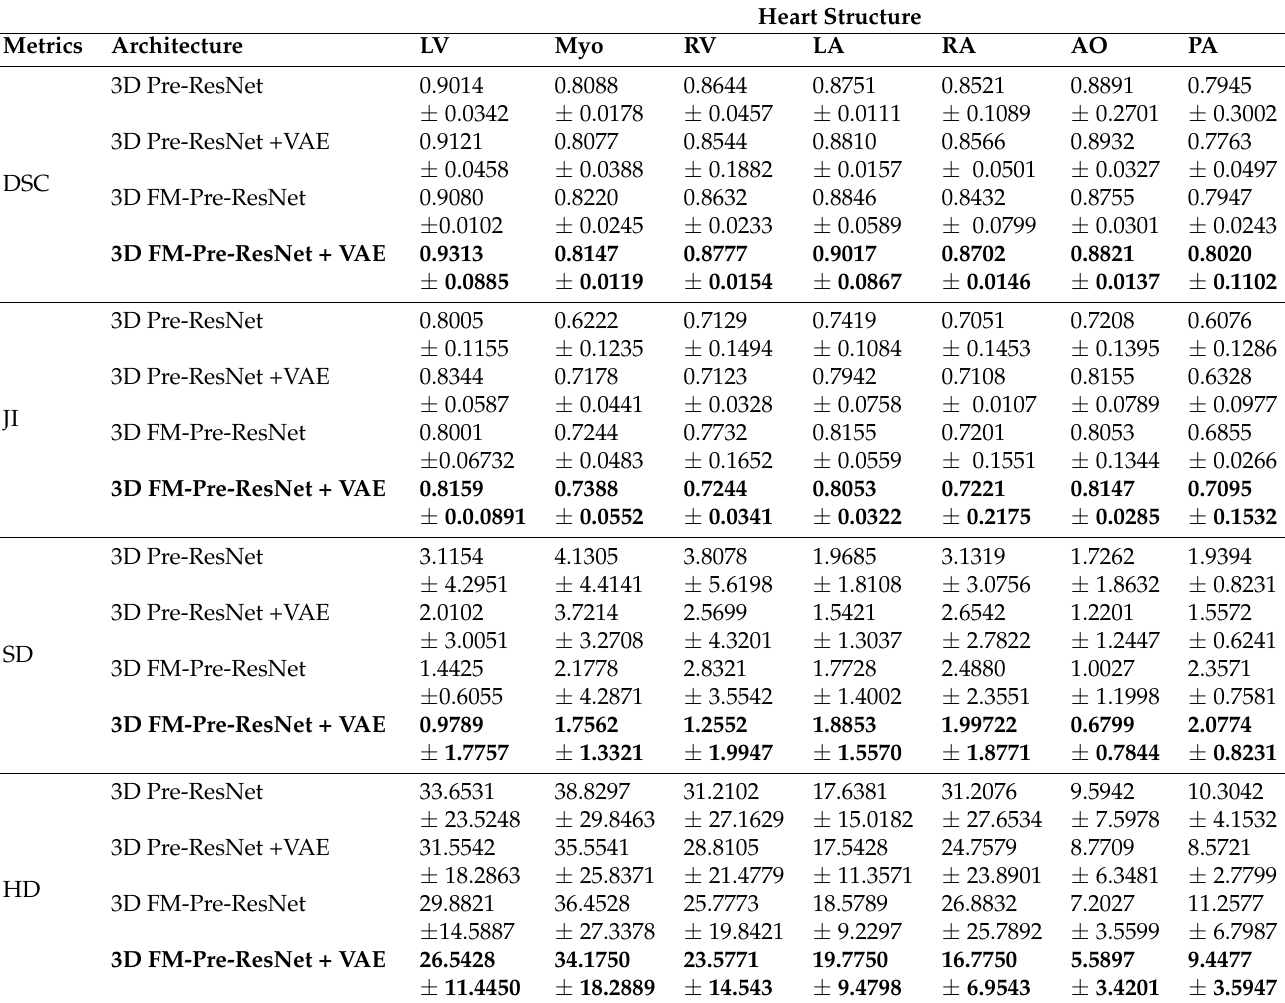
Table 4. Structure-wise DSC evaluation of proposed architecture and other 3D based architectures in terms of DSC, JI, HD, SD on MRI testing dataset for LV, RV, LA, RA, Myo, Ao, and